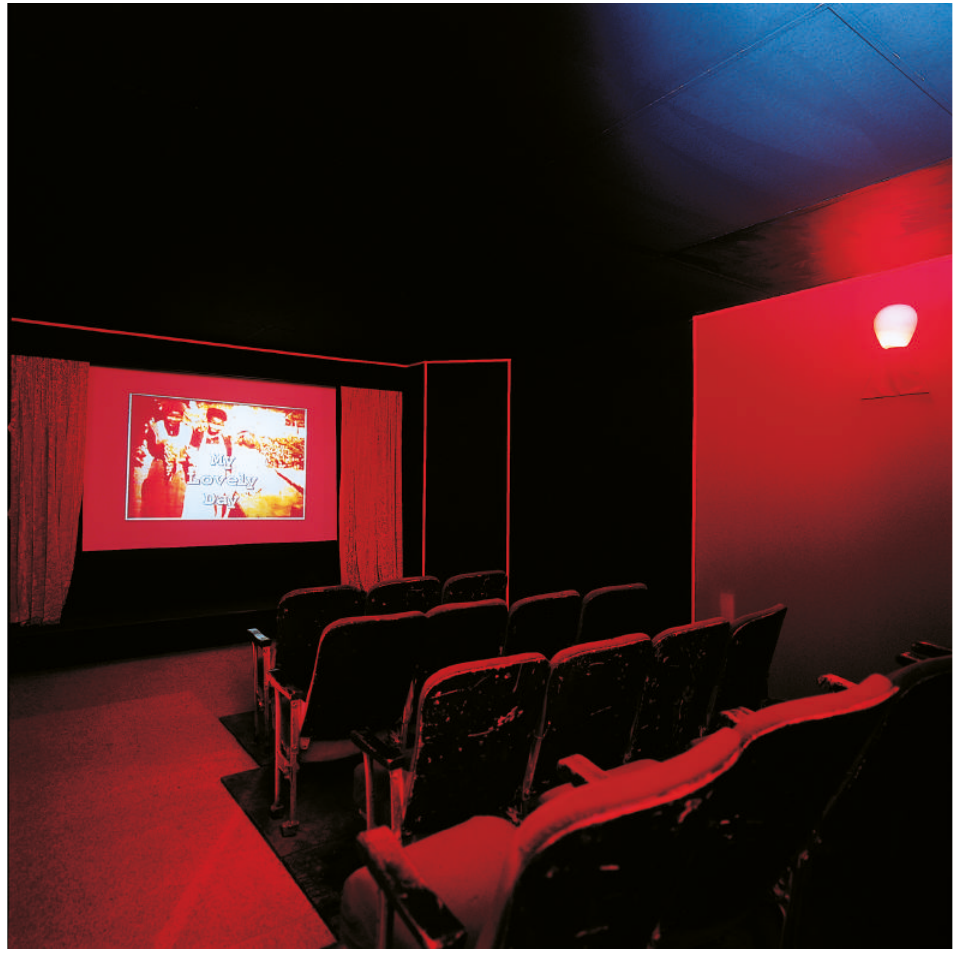
Figure 1 Penny Siopis, My Lovely Day (installation view), 3 rd ed., 1997. Video installation of mini cinema and 8mm film transferred to video, 21 minutes. Museum of Modern Art, Stockholm; South African National Gallery, Cape Town; the artist (photo: courtesy Penny Siopis and Stevenson Gallery, Cape Town).